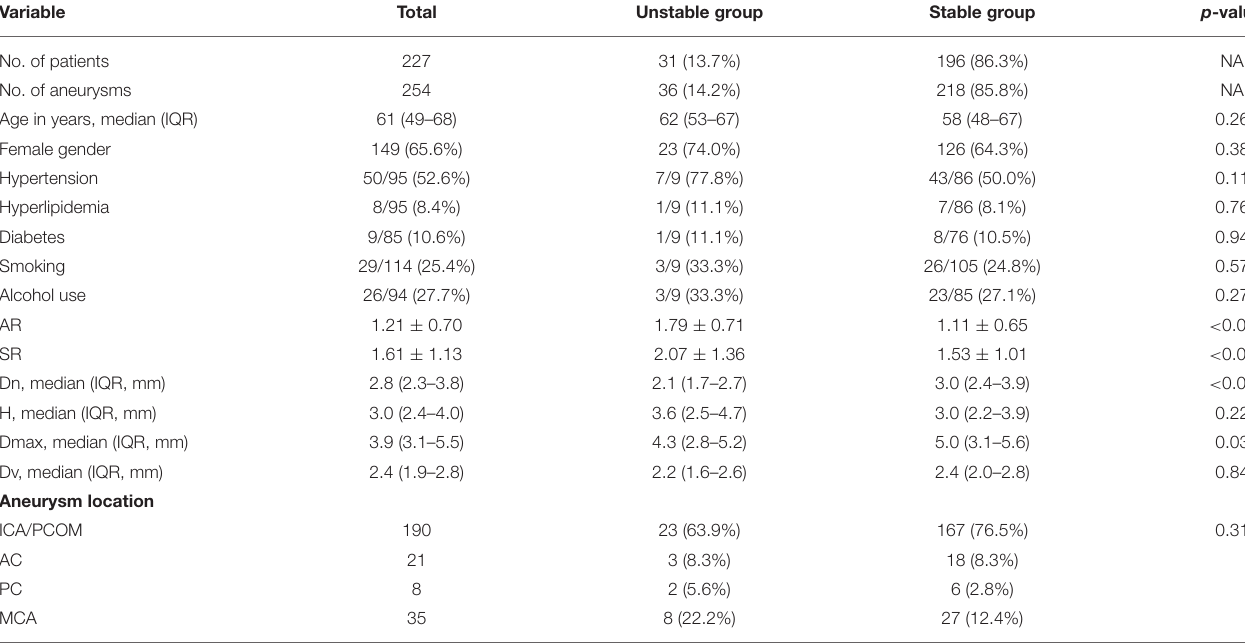
TABLE 1 | Traditional morphological characteristics of included patients and aneurysms.